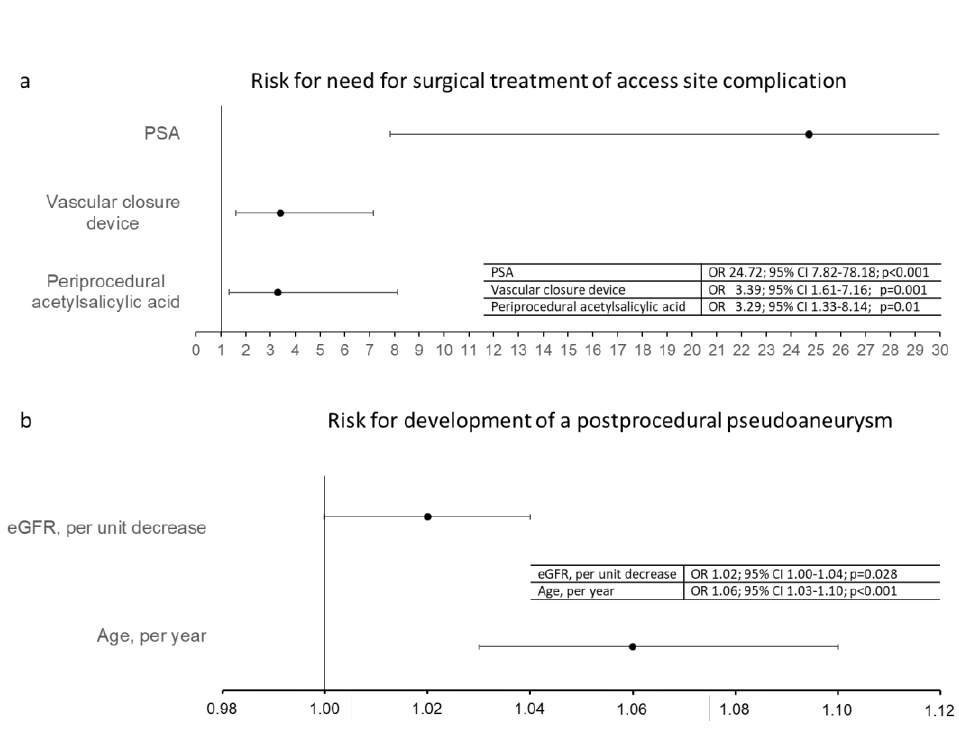
Figure 2. Forest plot showing risk factors for outcome. ( a ): Risk factors for need for surgical treatment of access site complication. Pseudoaneurysm (PSA), vascular closure device and periprocedural acetylsalicylic acid were identified as risk factors by logistic regression analysis. ( b ): Risk factors for the development of a postprocedural pseudoaneurysm Decreasing eGFR and increasing age were identified as risk factors by logistic regression analysis.